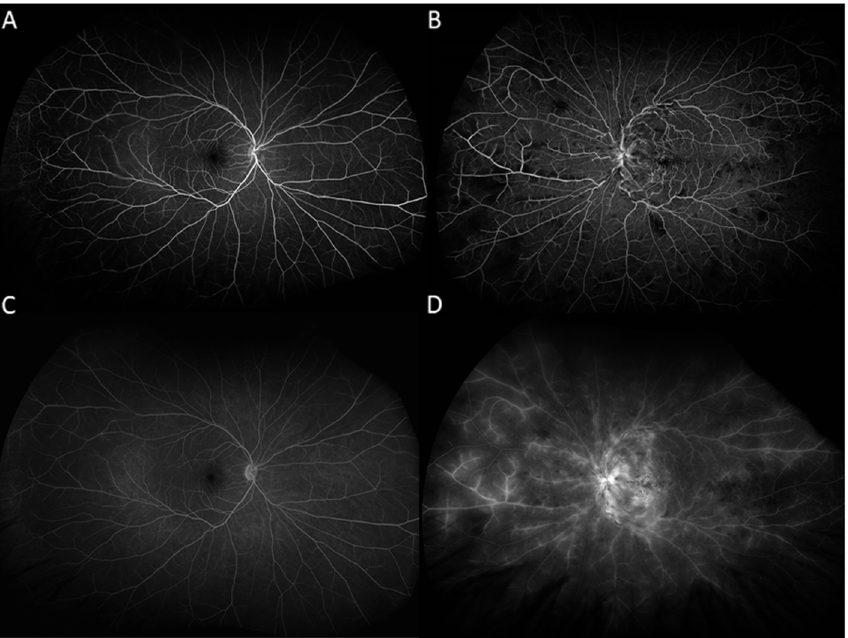
Fig. 2 Wide-field fluorescein angiography shows no retinal vascular leakage in the right eye ( A , C ). In the left eye there is peripheral ischemia seen in early and late frames with disc leakage, macular leakage, and diffuse, large vessel, vascular leakage predominantly affecting the venules ( B , D